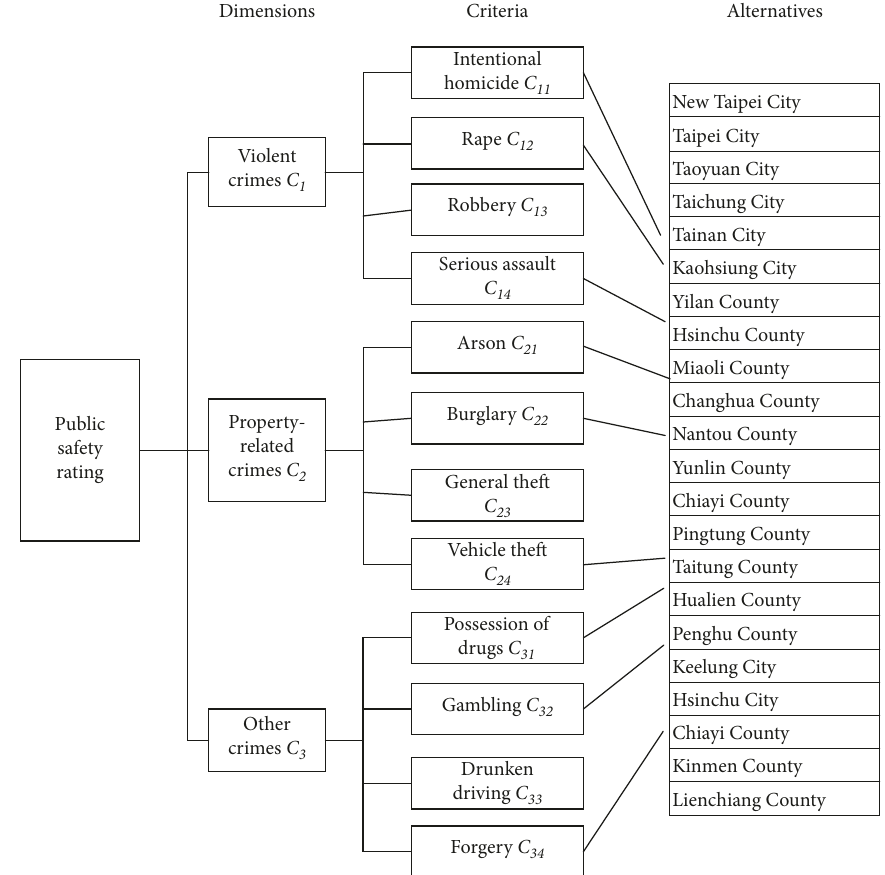
Figure 2: Public safety rating-based hierarchical structure for cities and counties in Taiwan. Table 1: Weights of public safety-related dimensions and criteria. Goal First-level